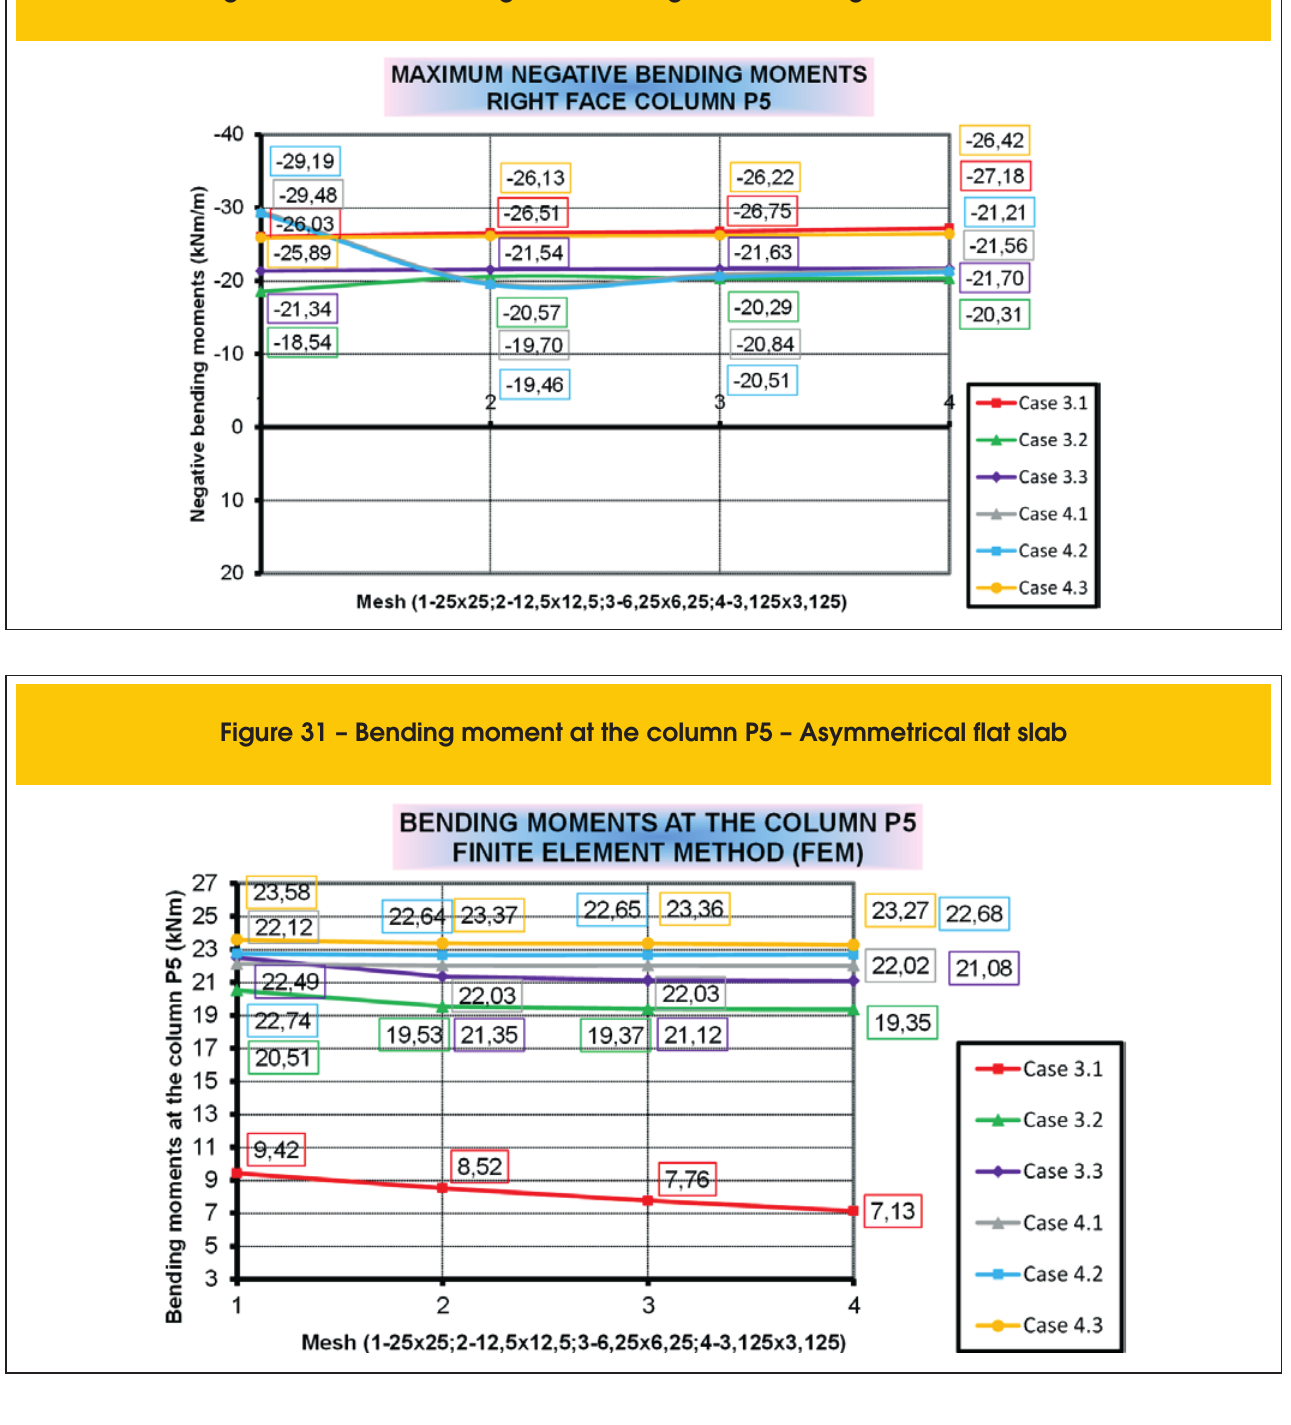
Figure 30 – Maximum negative bending moments - Right face column P5